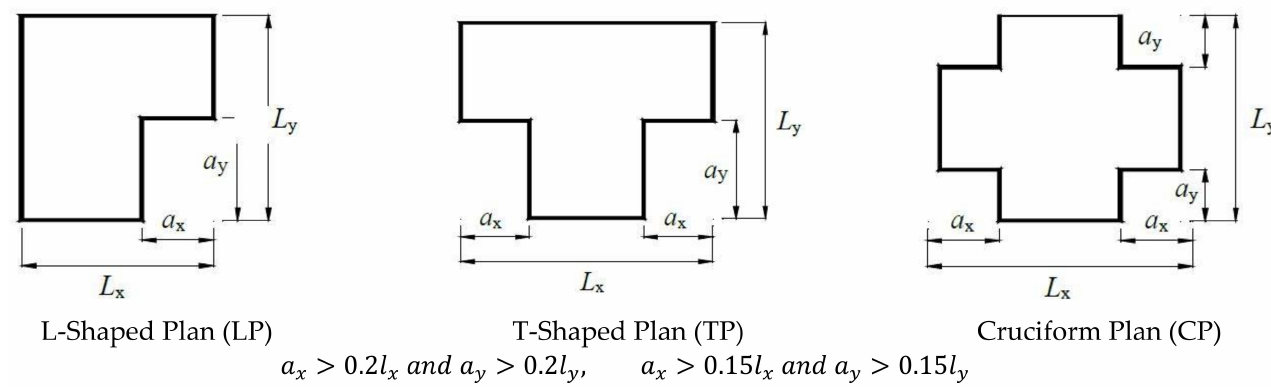
Figure 1. Buildings with plan irregularity.